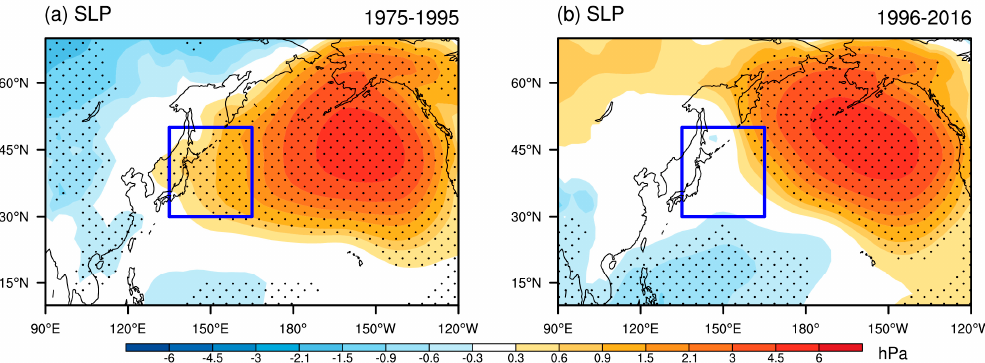
Figure 6. ( a ) The wintertime SLP regressed on the normalized the Aleutian Low index (ALI) over North Pacific region during 1975–1995. ( b ) As in ( a ), but for 1996–2016. Dots indicate the 90% confidence level based on a two-tailed Student’s t -test. The blue boxes in ( a , b ) indicate the region to define the KACI index.